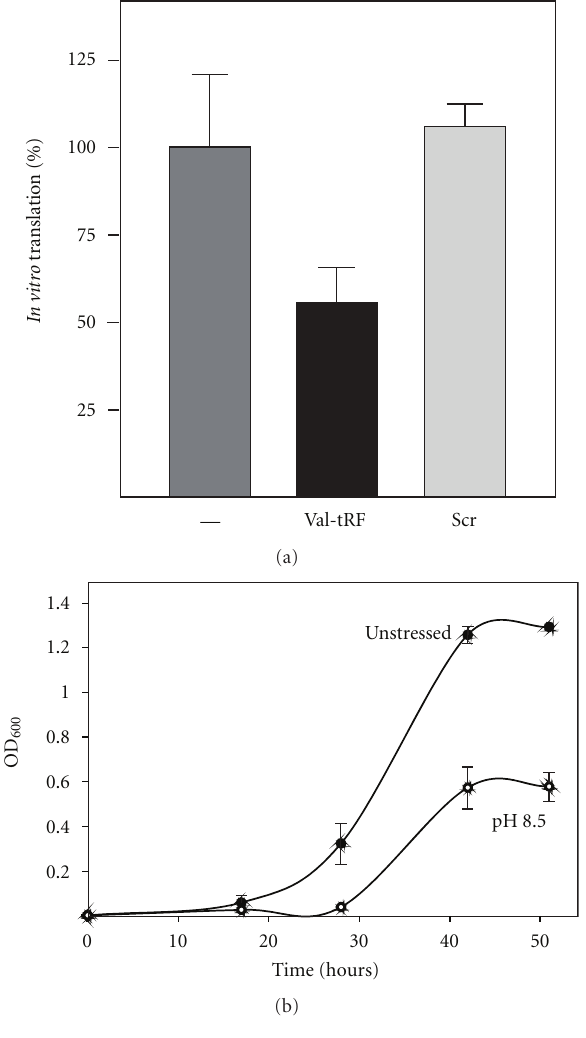
Figure 4: E ff ects of Val-tRF or elevated pH on protein synthesis and cell growth. (a) Val-tRF inhibits H. volcanii in vitro translation. The relative amount of radiolabeled proteins in the absence (-) or in the presence of 3.3 μ M Val-tRF is shown. The scrambled version of the Val-tRF (scr) served as specificity control. In all cases, the background values measured in reactions without S30 extracts were subtracted from all experimental points. Error bars represent the mean and standard deviation of at least three independent experiments. (b) Cell growth of unstressed H. volcanii cultures and of cells grown under alkaline conditions (pH 8.5) is shown. Cell density was measured at 600 nm and the average values of two independent growth curves each and their standard deviations are given.